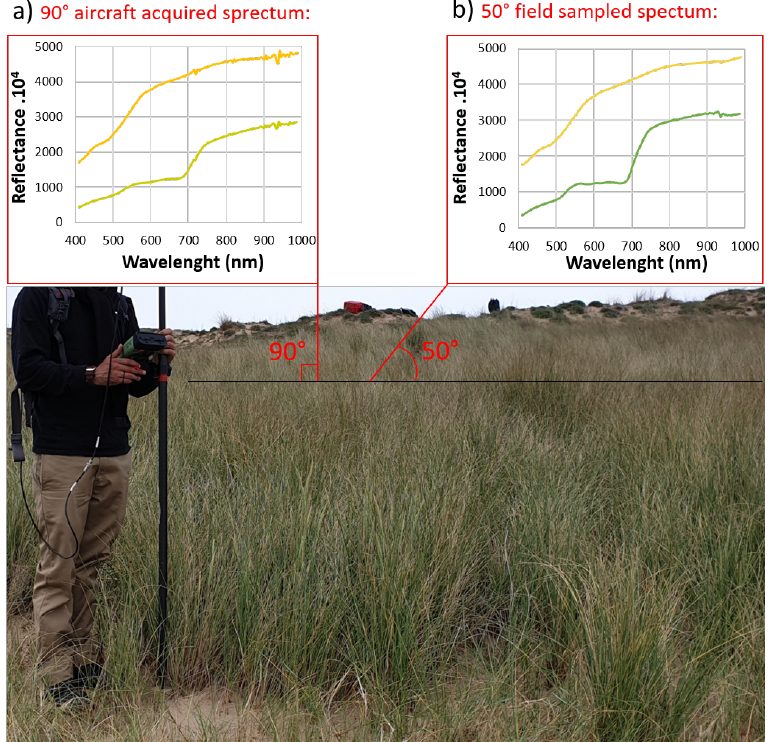
Figure 3. Ammophila arenaria mean spectra. ( a ) The light green curve represents the Ammophilia arenaria mean spectrum, acquired from a 1500 m distance with a 90 ◦ ± 8.5 ◦ angle, whereas the yellow curve represents a dry sand mean spectrum, acquired with the same camera; ( b ) the dark green curve represents the Ammophila arenaria field sampled mean spectrum, acquired at a distance of 1 m, following a 50 ◦ ± 5 ◦ angle, whereas the yellow curve represents the dry sand mean spectrum acquired using an ASD field